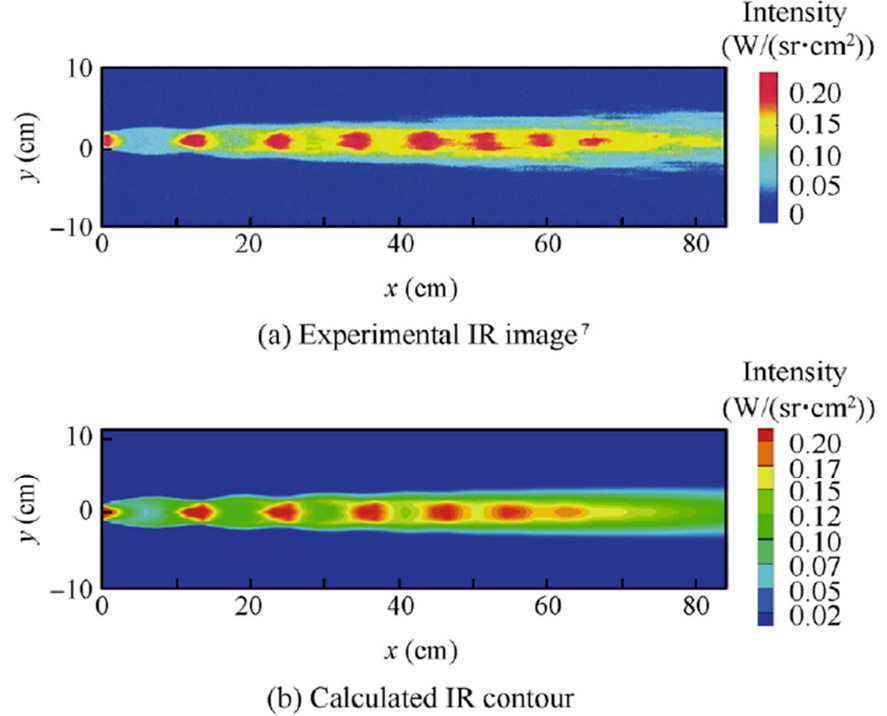
Figure 8. Comparison of experimental and calculated infrared images of the plume by Avital et al. [33] with the scan bandpass filter of 4.372–4.516 μ m. Reprinted with permission from Ref. [30] (2017).